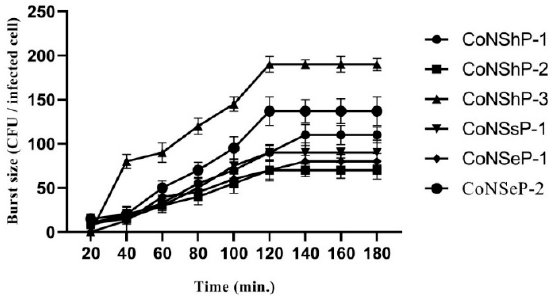
Figure 3. Single-step growth curve of the six CoNS isolated phages (CoNShP-1, CoNShP-2, CoNShP-3, CoNSsP-1, CoNSeP-1, and CoNSeP-2); values of burst size and latency period were represented vertically and horizontally, respectively.